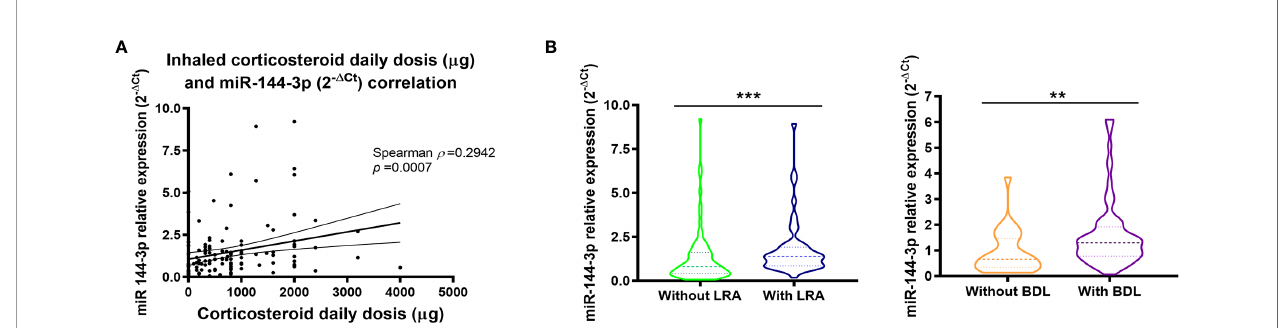
FIGURE 3 | Serum miR-144-3p expression is associated with high inhaled corticosteroid dose. (A) Relative miRNA expression of miR-144-3p (2 - D Ct ) in serum correlates directly with daily corticosteroid use ( m g). (B) miR-144-3p relative expression (2 - D Ct ) is increased in asthmatics with leukotriene receptor antagonist and bronchodilator treatment. Results are shown as median and quartiles. ** p < 0.01; *** p < 0.001. LRA, leukotriene receptor antagonists; BDL, bronchodilators.